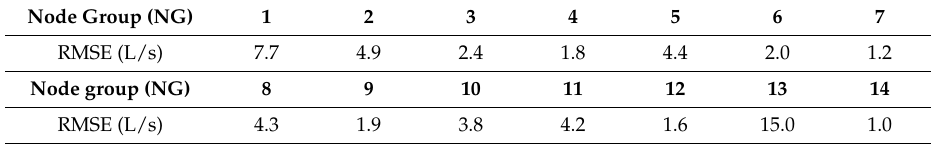
Table 1. Node group demand estimation RMSE (sum of node group demands’ RMSE = 56.2 L/s). Node Group